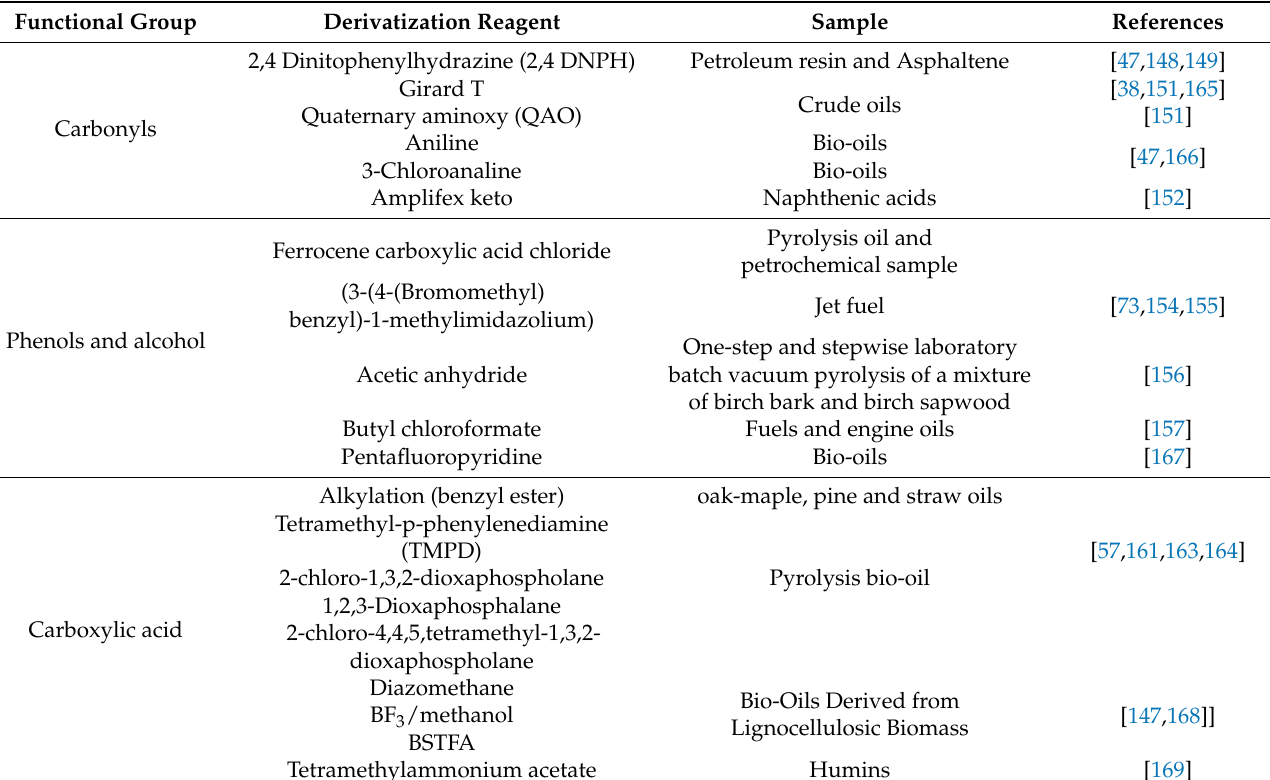
Table 4. Examples of derivatization reagent used to modify oxygenated functional groups in